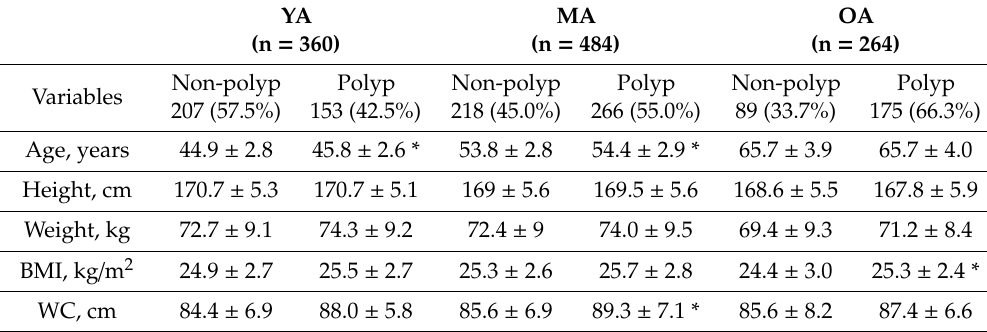
Table 1. Characteristics of subjects.